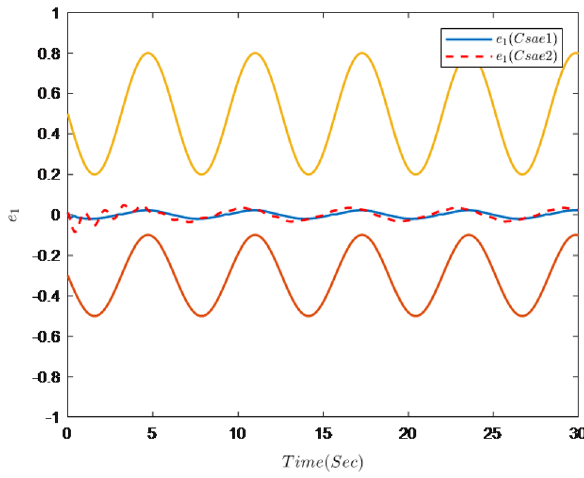
Figure 12. Trajectories of tracking error e 1 and constraint